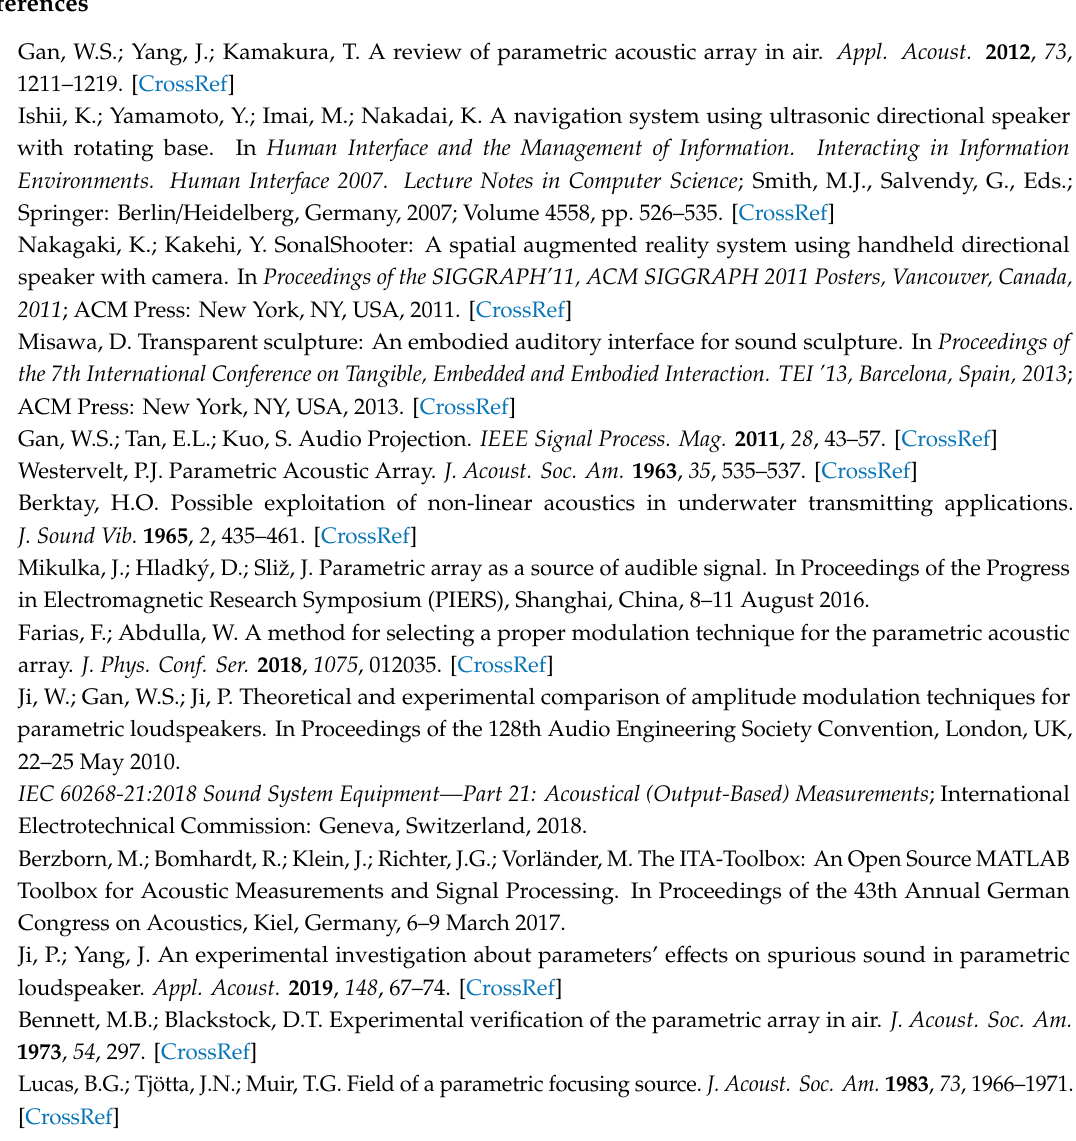
Table SI: Main characteristics of the evaluated microphones, Figure S1: Block diagrams of preprocessing amplitude modulation techniques, Figure S2: Spectrogram of the signals corresponding to each stage of the measurement procedure, Figure S3: Harmonics up to the 5th order measured with the predistortion techniques (m = 1), Figure S4: Level of total harmonic distortion (LTHD) for the predistortion techniques at di ff erent modulation indices, and Figure S5: Intermodulation distortion (IMDT) for the predistortion techniques applied with di ff erent levels of modulation index